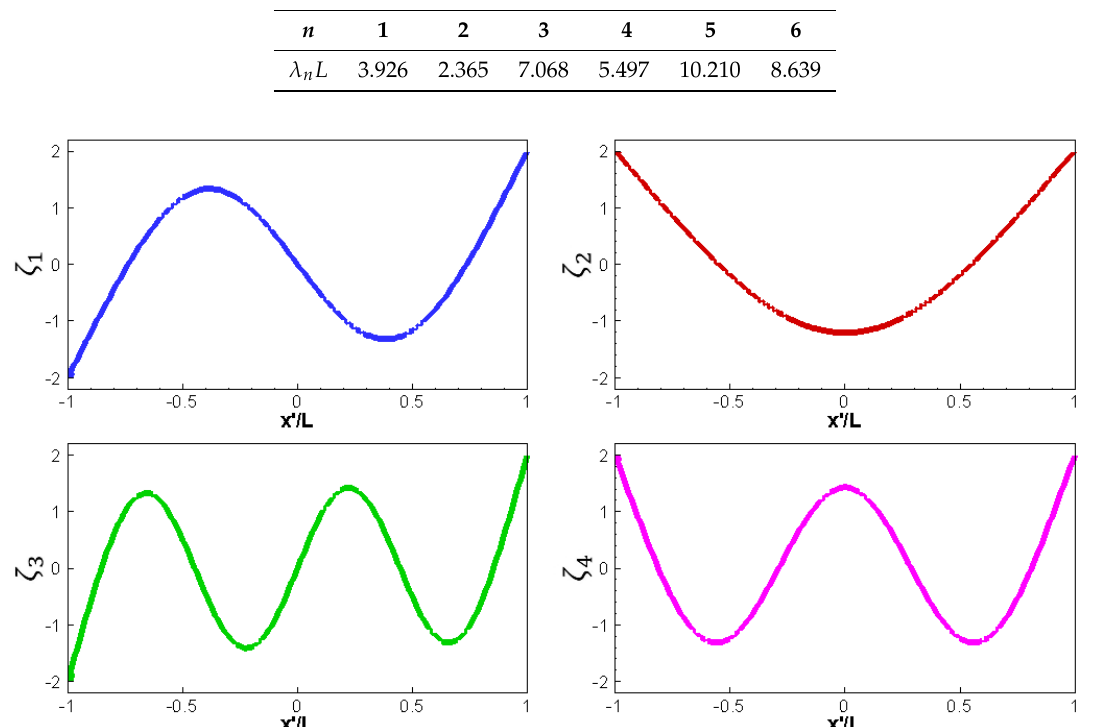
Figure A1. Plate vibration modes.